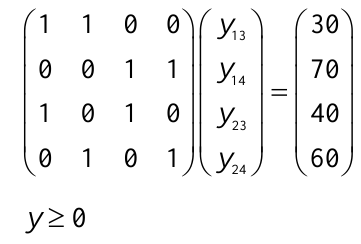
Figure 4: NTE link time subject